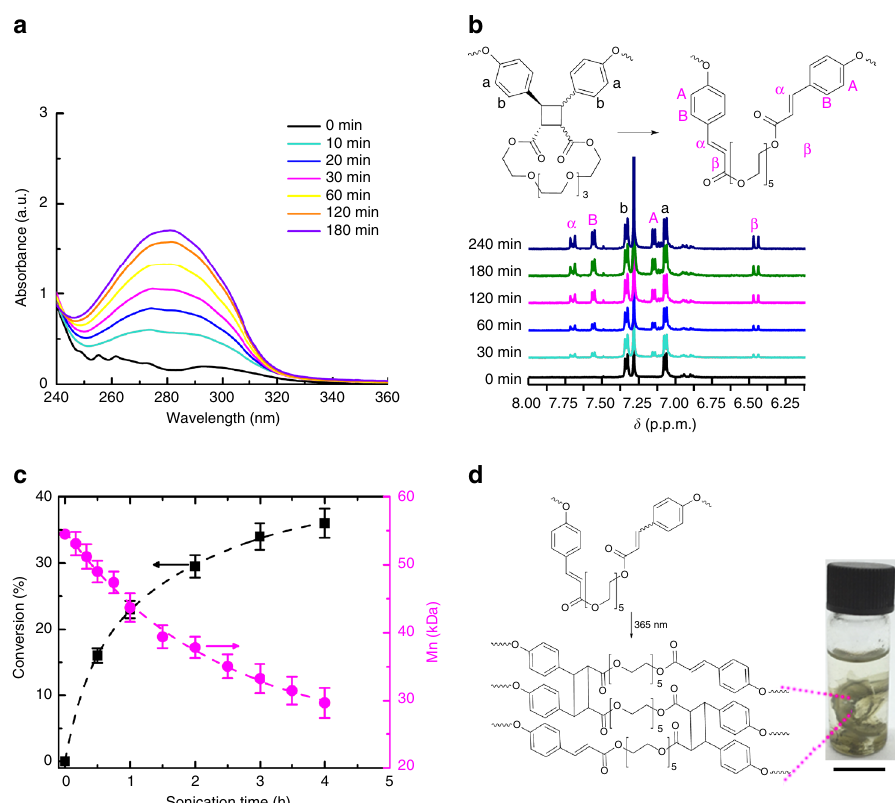
Fig. 5 Summary of mechanochemistry of macrocyclic cinnamate dimers in solution. a , b The evolution of the UV-vis ( a ) and 1 H NMR ( b ) spectra of a solution of P2 ( M n = 54 kDa) during sonication is consistent with dissociation of dimers 2a to cinnamates, as evidenced by increases in the intensities of ( a ) the characteristic absorption band at 280 nm in UV and ( b ) 1 H NMR resonances of the vinyl protons (marked α and β ). c As is typical, sonication of P2 resulted in competition between dimer dissociation (black curve and y -axis), which does not reduce the polymer size, and random chain fragmentation (magenta curve and y -axis), which does. Conversion % (black curve) was determined as (1 + r ) − 1 , where r is the ratio of the intensities of the 1 H NMR resonances marked b and B in Fig. 5b. This conversion % correlates well with the absorbance at 280 nm (Supplementary Fig. 17). Error bars are standard deviations. d Irradiating mechanically degraded P2 creates an insoluble material, most likely by [2 + 2] photodimerization of cinnamates. The scale bar